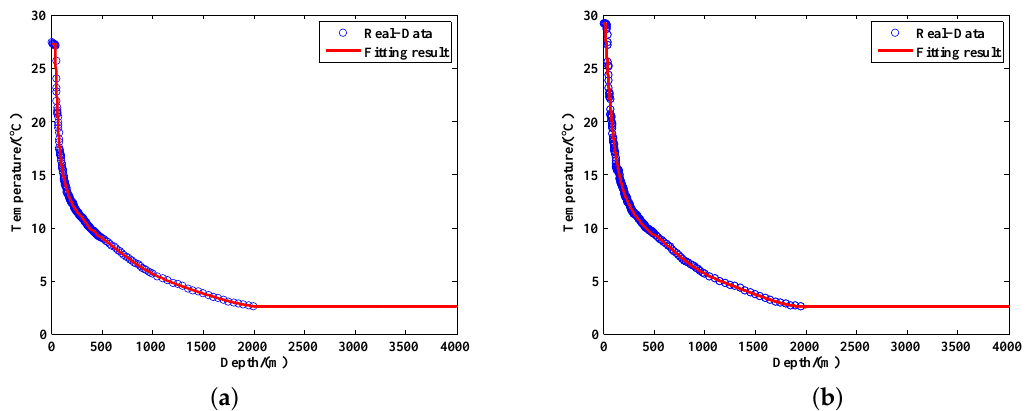
Figure 10. The fitting result of the temperature data in the equator area. Panel ( a ) shows the seawater’s temperature data in summer and ( b ) shows the seawater’s temperature data in